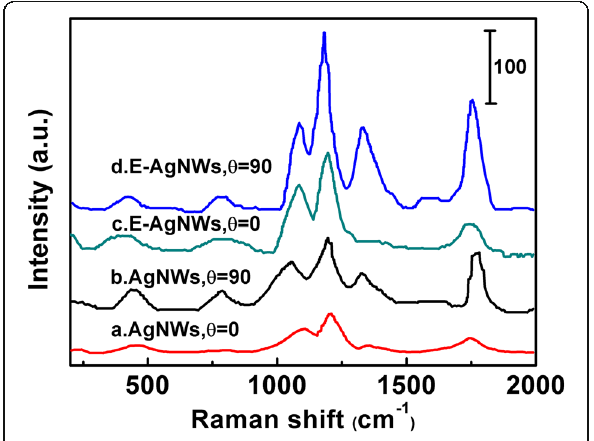
Fig. 7 SERS spectra of RB on different nanowire monolayers taken at different polarization directions of incident light. The angle θ is the angle between the polarization direction and the long nanowire